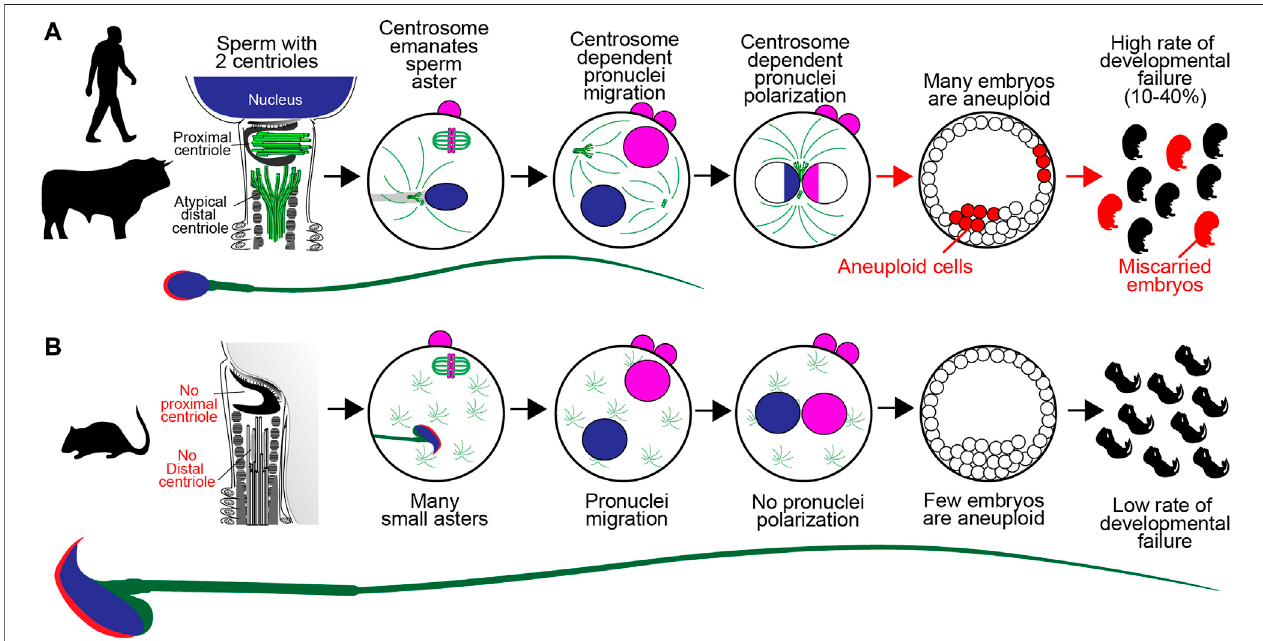
FIGURE 1 | A Model of Sperm Centriole Function Post-fertilization. (A) In human, bovine, and many other mammalian species, the sperm has two centrioles: the proximal centriole and atypical distal centriole. During fertilization, spermatozoan centrioles are brought into the oocyte, where they form the large sperm aster, or the zygotic centrosome, and which helps pronuclear migration. The initial, single zygotic centrosome breaks into two centrosomes that move to the interface between the twopronuclei,wheretheypolarizethepaternalgenome(blue)andmaternalgenome(pink).Failureofthespermcentrioles(redarrow)orzygoticcentrosomeresults in embryo aneuploidy (red x) and embryo developmental failure, which are common in human and bovine. (B) In mice, the sperm has no detectable centrioles. After fertilization,themanysmall,acentriolar,cytoplasmicastersintheoocytecontinuetofunction.Thepronucleargenomesarehomogenous.Embryoaneuploidyisverylow, and embryo development is